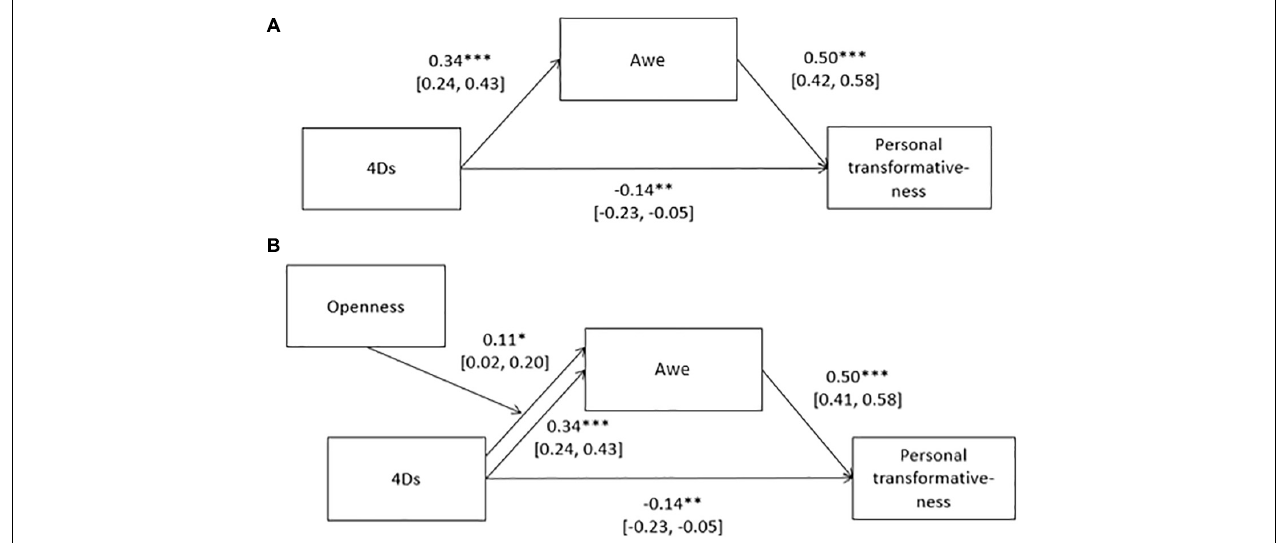
FIGURE 2 | Mediation models testing the effect of the 4Ds on personal transformativeness via awe; (A) without moderator of openness (B) with moderator. Standardized beta coefficients with 95% CIs. ∗ p < 0.05, ∗∗ p < 0.001, ∗∗∗ p < 0.001. on awe ( F (3, 477) = 11.27, p < 0.001). Bonferroni-corrected